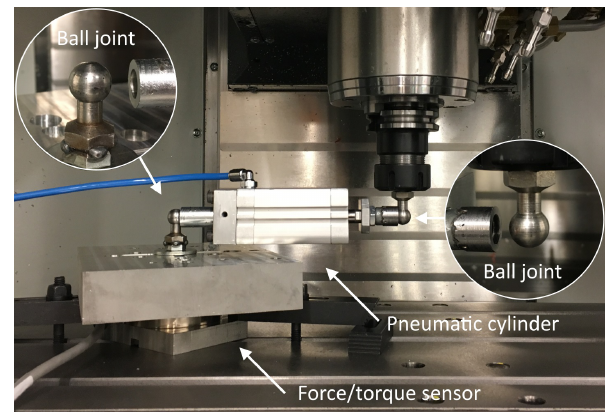
Figure 4: 3-axis CNC: General test setup with pneu- matic cylinder and force/torque sensor.